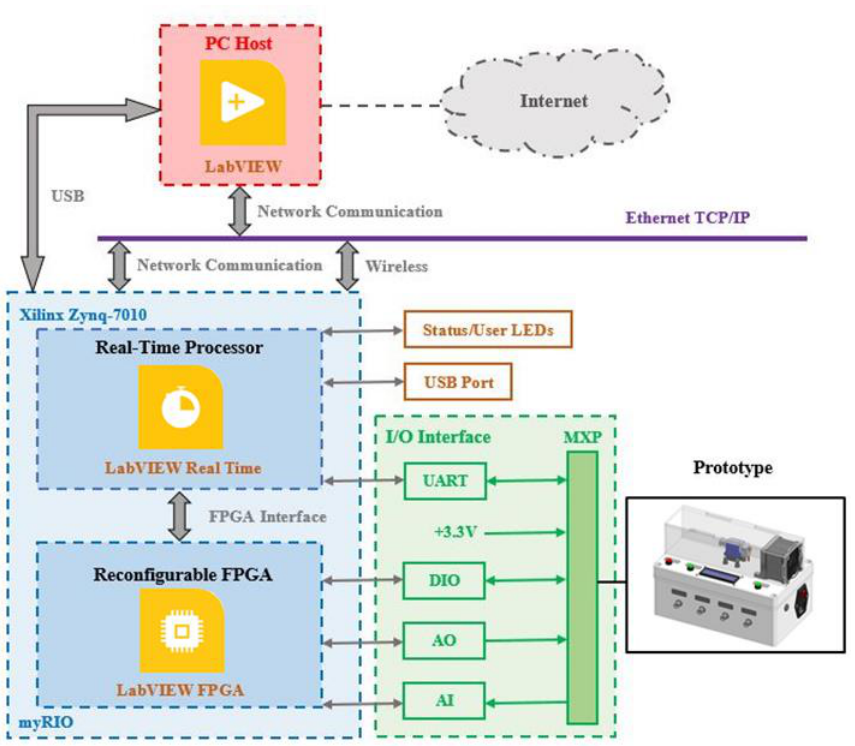
Figure 5. Proposal of hardware architecture applied to the laboratory prototype. The interaction between hardware and software is also illustrated.